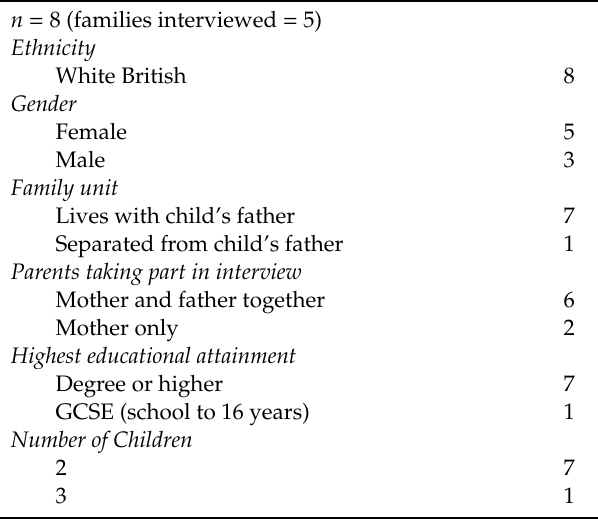
Table 1. Characteristics of